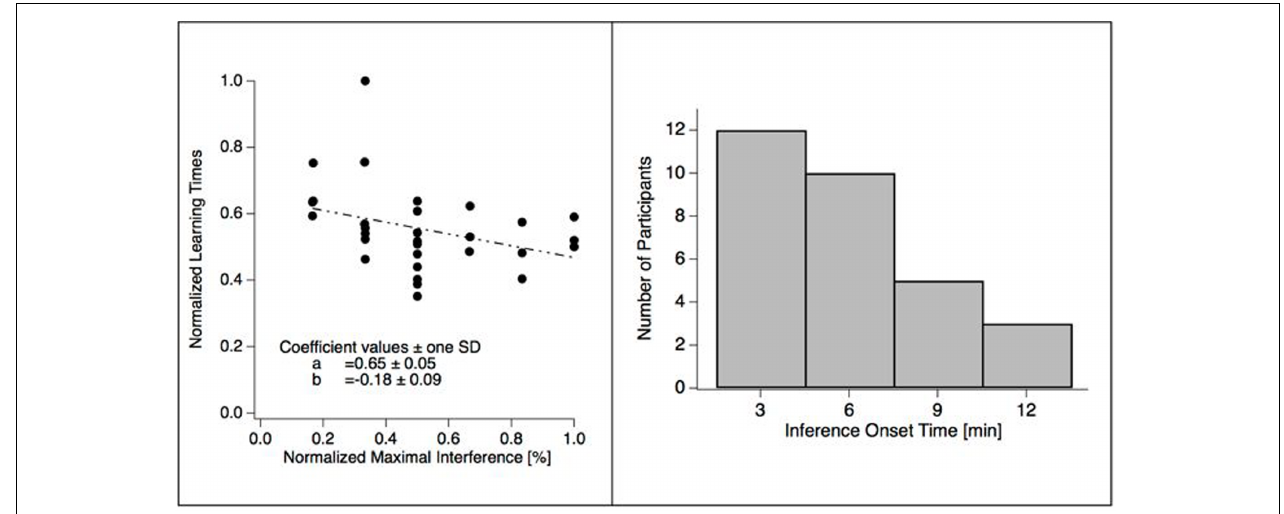
FIGURE 3 | Temporal aspects of maximal interference. (Left) The scatter plot shows the maxima of individual interference as a function of learning time. Each dot represents one participant. The negative sloped dashed line represents a linear fit of the data and indicates a negative correlation between the two variables, i.e., fast learners are more susceptible to interference. (Right) The bar plot shows the numbers of participants with maximal interference values at each of the four interference time points after the initial learning sequence. Most participants peak at the first interference time point, however, location of the interference time point does not correlate with effect